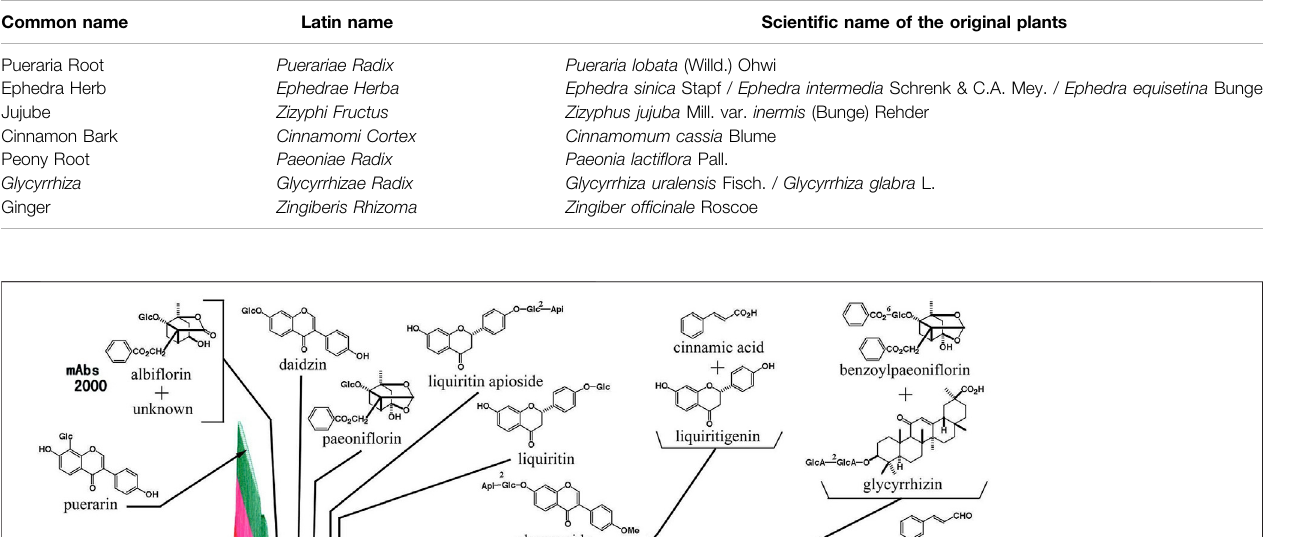
Frontiers in Pharmacology |